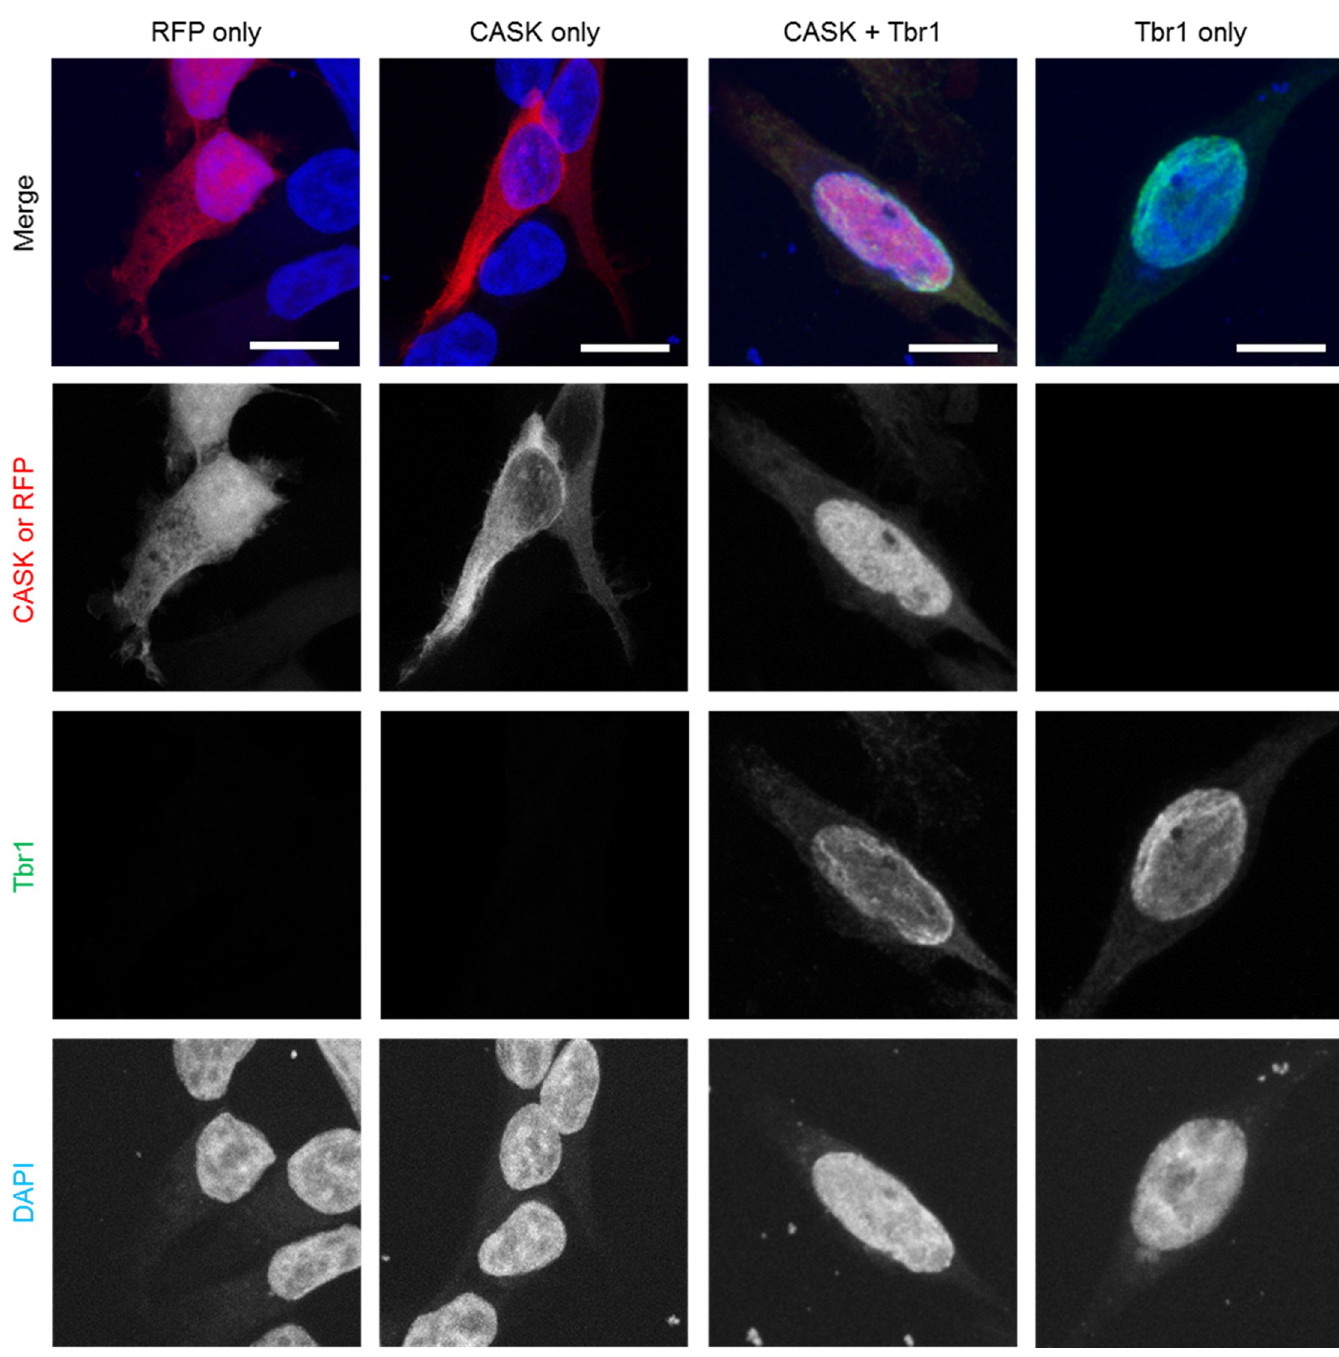
Fig 5. CASK localization switches from cytoplasmic to nuclear in the presence of Tbr1. HEK293-T cells were transfected with plasmids encoding a combination of RFP, RFP-CASK-WT and or Myc-Tbr1. Cells were fixed one day after transfection and fixed with paraformaldehyde. Myc and cellular nuclei were stained using α -Myc antibody and DAPI, respectively. Cells were imaged on a SP8 confocal microscope. Overexpressed RFP is present both in the cytoplasm and nucleus of the cells (column 1) while CASK is present primarily in the cytoplasm (column 2). However, in the presence of Tbr1, CASK localization changes almost entirely to the nucleus (column 3). Tbr1 is localized in the nucleus both with (column 3) and without CASK (column 4).